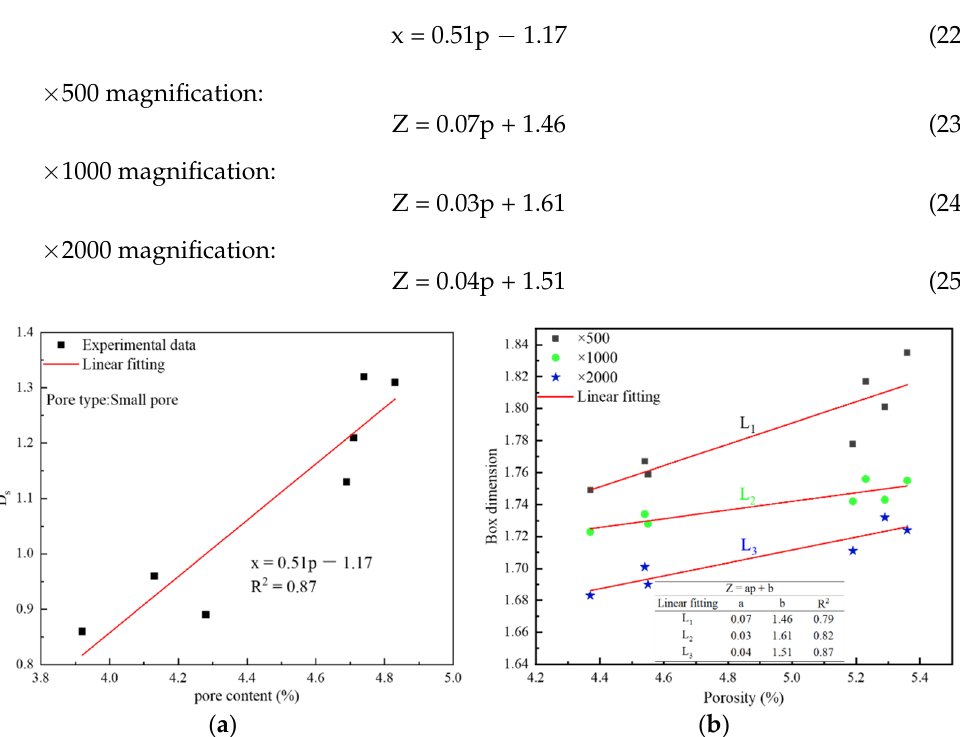
Figure 15. The functional relationship between pore content and dimension. ( a ): Relationship between pore content and small pore NMR-FT fractal dimension ( b ): Relationship between porosity and SEM-FT box dimension